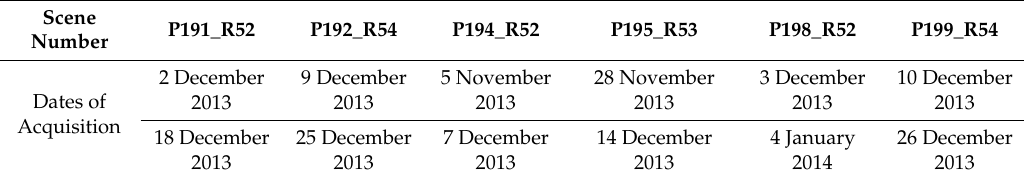
Table 1. Scene numbers and acquisition dates of Landsat OLI images analyzed in this